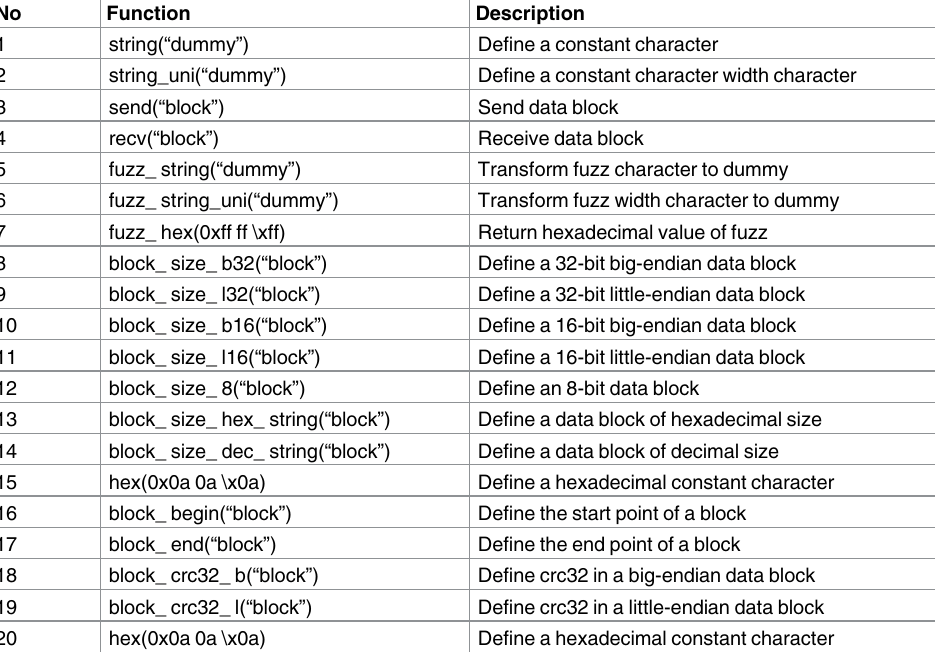
Table 1. Main functions in the block-based protocol description